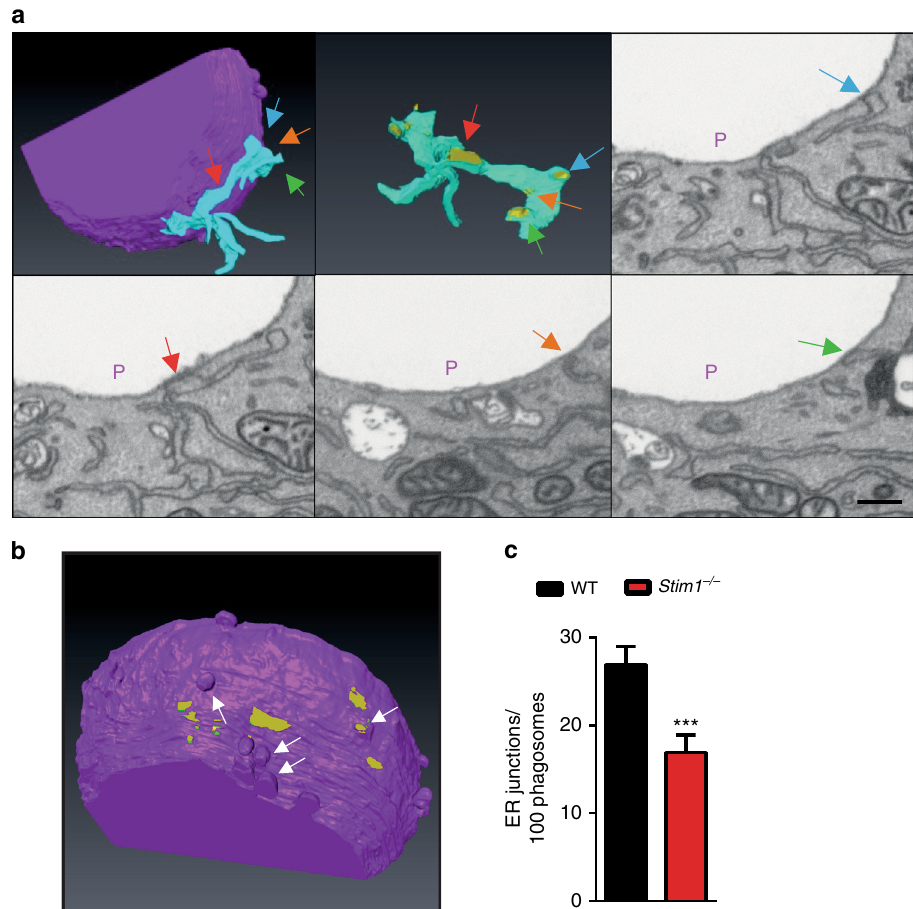
Fig. 4 STIM1 promotes ER – Phagosome membrane contact sites. a 3D reconstruction (top left and middle) of FIB-SEM images (top right and bottom) shows that contiguous ER membranes (light blue) make multiple contact sites (coloured arrows and yellow highlight) with a single phagosome (purple). b The vicinity of contact sites (yellow highlight) is associated with an increased occurrence of bulges in the phagosome surface away from the beads, reminiscent of vesicular fi ssion or fusion activity (arrows). c Quanti fi cation of FIB-SEM slices revealed that Stim1 ablation reduced the frequency of ER – Ph MCS (also called ER junctions). N = 55/26 slices representing a total of 170/35 phagosome cross-sections in WT/ Stim1 − / − BMDCs respectively. OVAb added at 20:1 targets:cells, cells fi xed 30min after exposure to targets. Bar = 100 nm. Error bars are means+SEM, * p < 0.5, ** p < 0.1 using a Student ’ s t